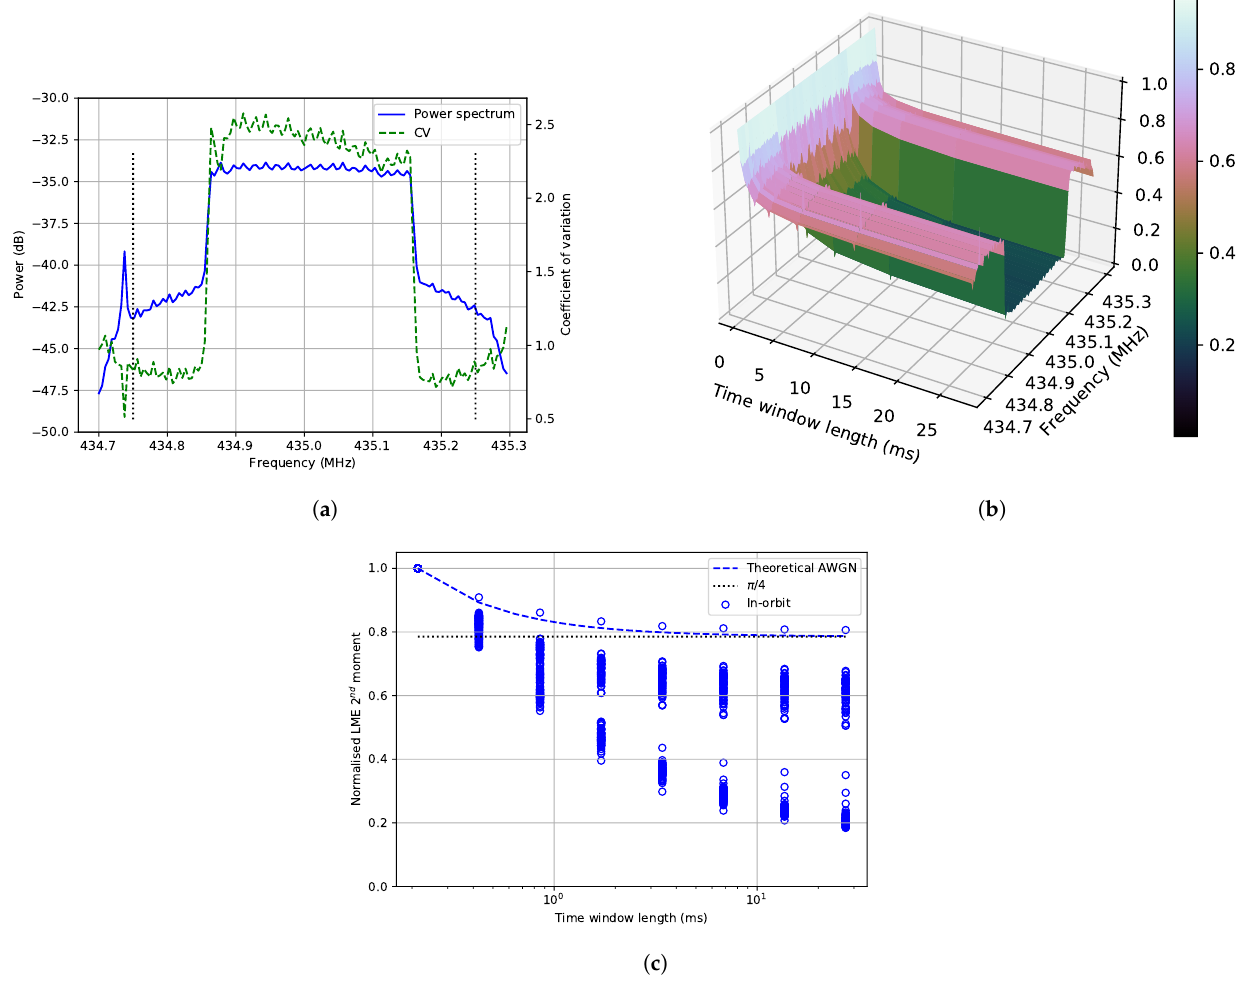
Figure 11. Example of a five second measurement with different types of signals over Greenland. ( a ) Average power spectrum ( m 2 k ) and coefficient of variation. If there was no time variability in the mean, it would be zero. ( b ) Normalised LME second moment for different time windows for all frequency bins in 3D. ( c ) Normalised LME second moment for different time windows for all frequency